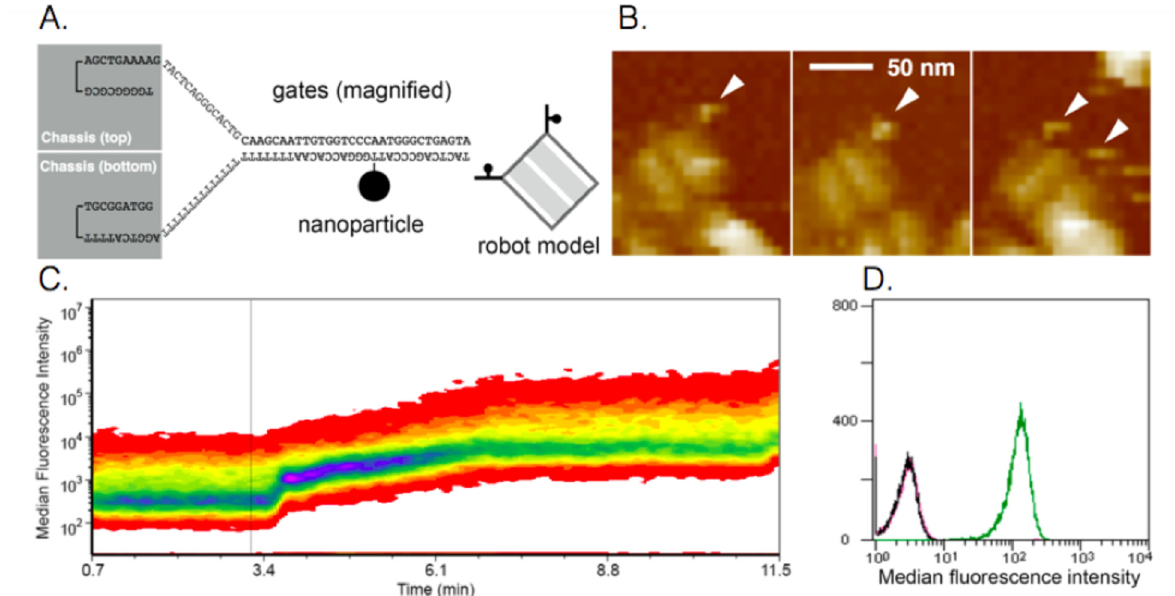
Fig 2. Remote-controlled DNA robot design and performance. (A) schematic showing the link between robot and metal nanoparticle, on a magnified portion of the gate strand. A nanoparticle is chemically linked to one strand of each gate as shown in the robot model. (B) AFM images of robots conjugated with nanoparticles. (C) RFMF-induced activation of robots and subsequent staining of target cells with fluorescent antibodies loaded inside the robots. Fluorescence is monitored in real-time by flow cytometry. (D) Flow cytometric validation that transient RFMF-induced activation does not destroy the robots (black, closed robots; green, open robots; magenta, transiently RFMF-activated robots).